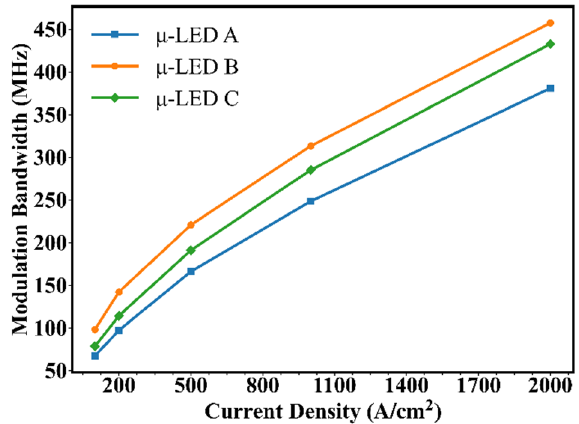
Figure 6. The − 3 dB modulation bandwidth vs. current density for μ -LED A, μ -LED B, and μ -LED C.